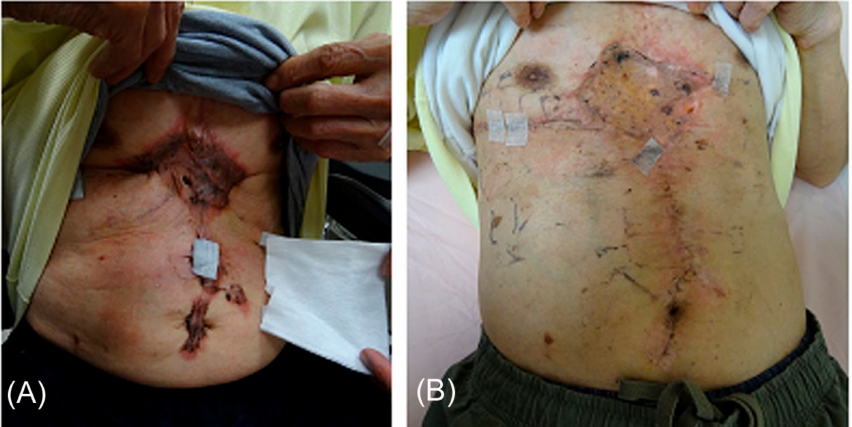
Figure 5. ( A ) Pre-treatment and ( B ) post-treatment images of the keloid of one patient treated with helical tomography. Post-treatment, the scar was white and not elevated. Additionally, the patient reported no tightness, itching, or painful